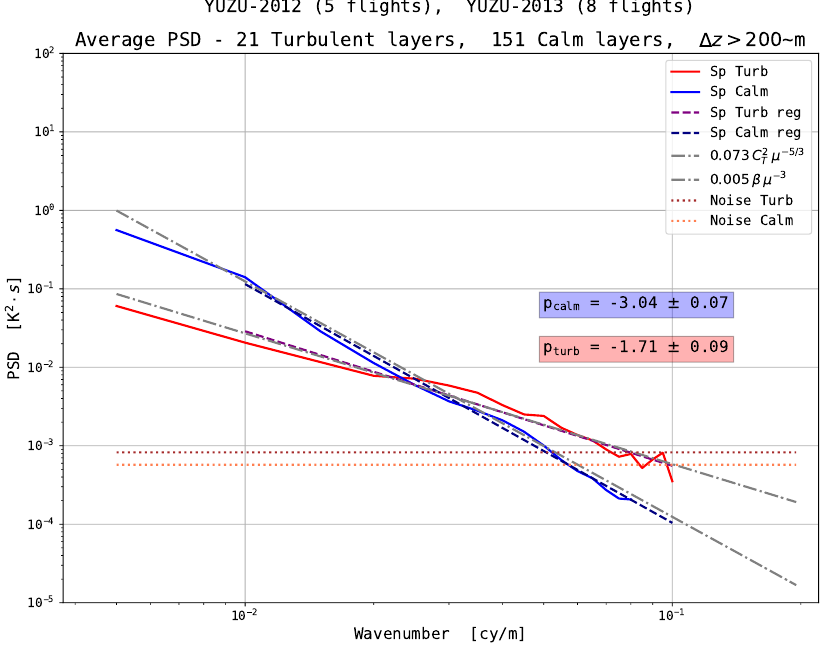
Figure 10. The mean spectra of 41 turbulent layers thicker than 300 m (red curve) and of 109 laminar layers (blue curve) resulting from 16 radiosonde profiles. The dashed lines show the (log-log) linear fit of the power spectra for the 10–100 m domain of scales. The spectral index for both the calm and turbulent spectra are indicated in the colored boxes. The dot-dashed gray curves show the theoretical spectra for turbulence and saturated gravity waves.